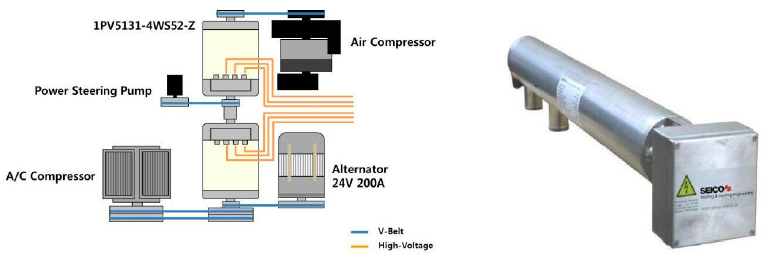
Figure 7. HVAC system and braking